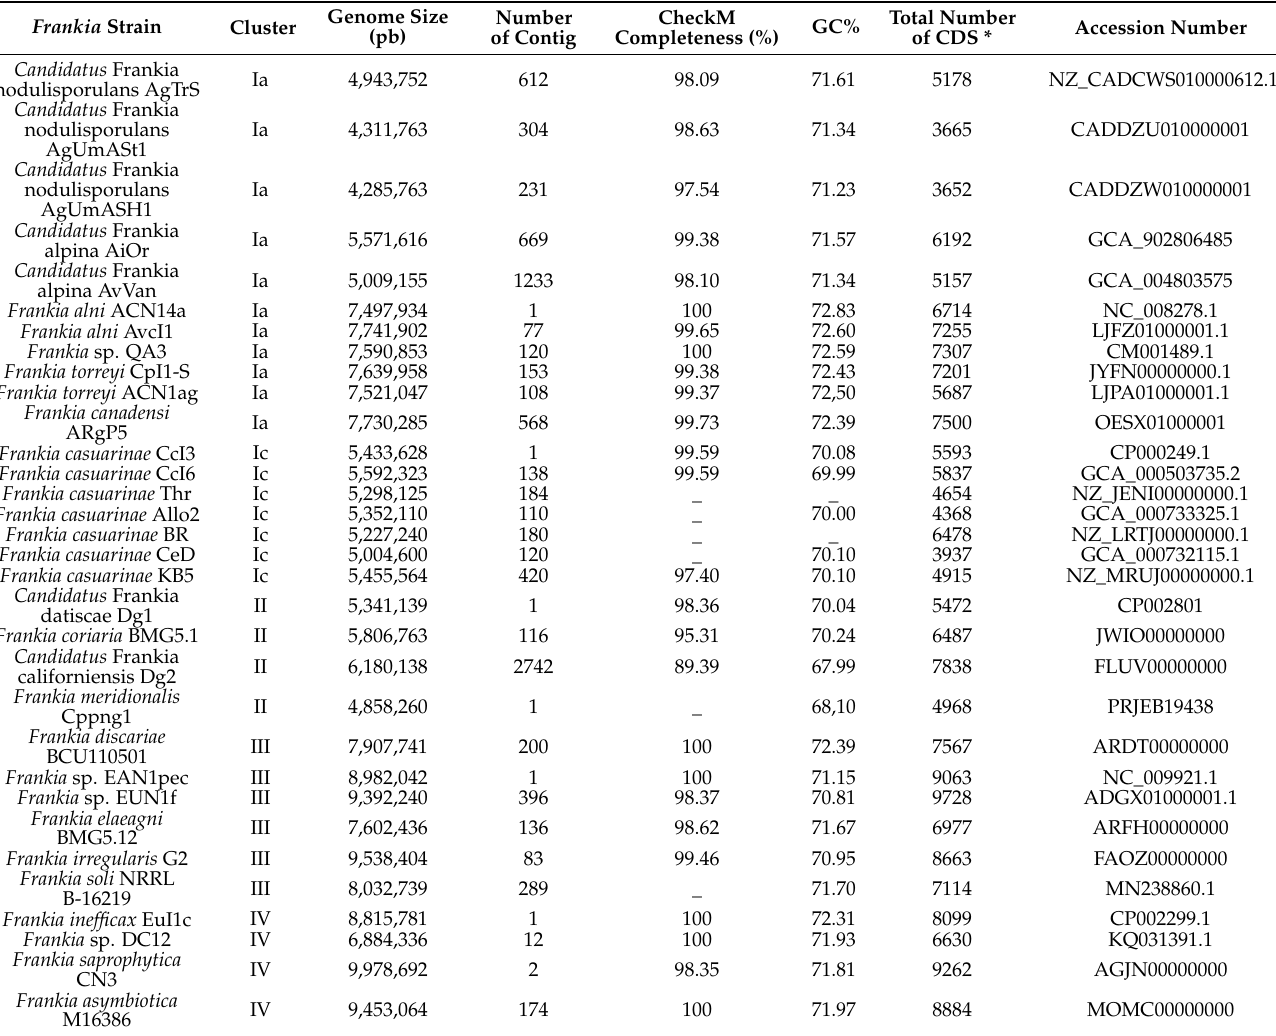
Table 1. List of the 32 Frankia genomes